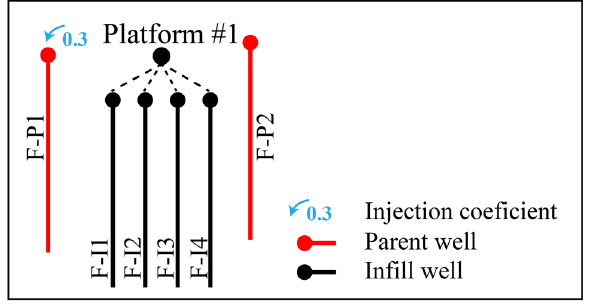
Fig. 22 Schematic diagram of the two parent wells and the four infill wells in the F region